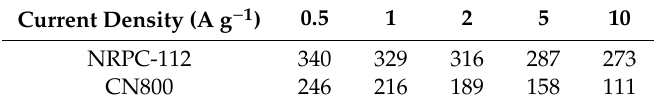
Table 3. Capacitances of NRPC-112 and CN800 in various current densities (F g − 1